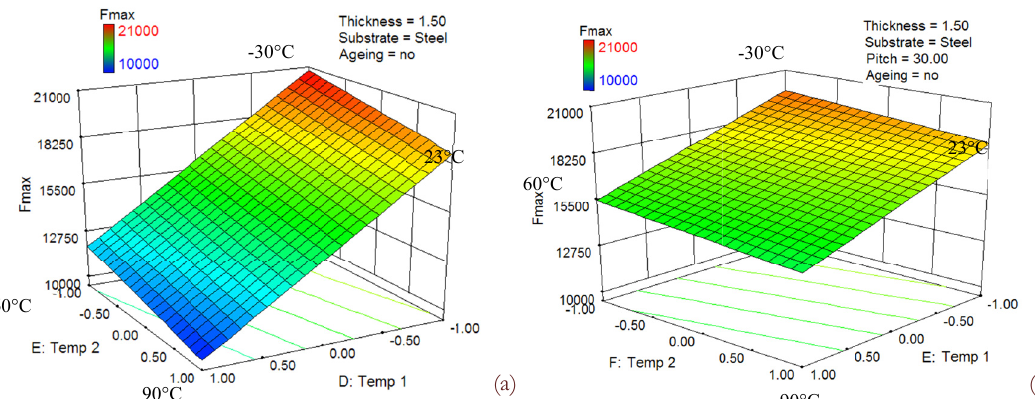
Figura 13 Comparison b